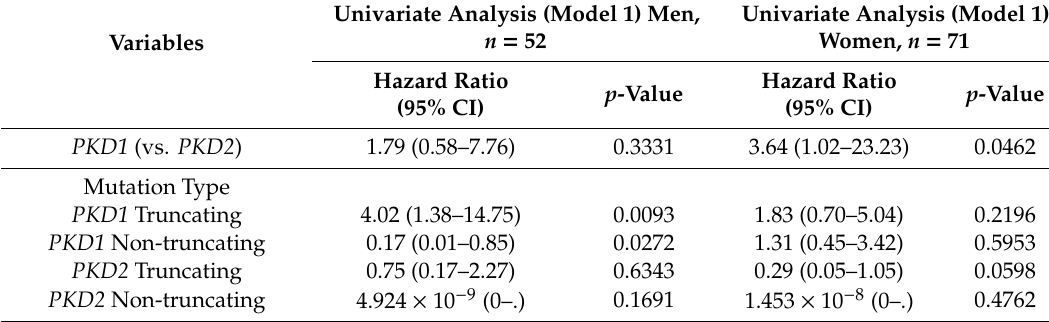
Table 5. Univariate analysis of risk factors associated with RRT in the cohort stratified by sex.